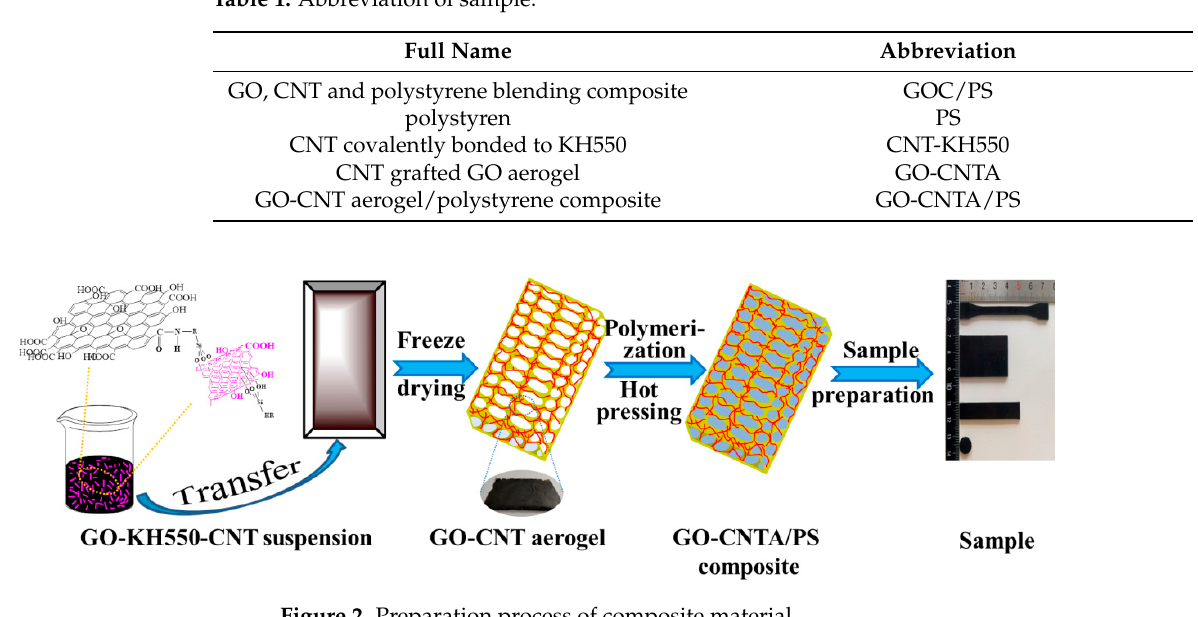
Figure 2. Preparation process of composite material. Table 1. Abbreviation of sample.